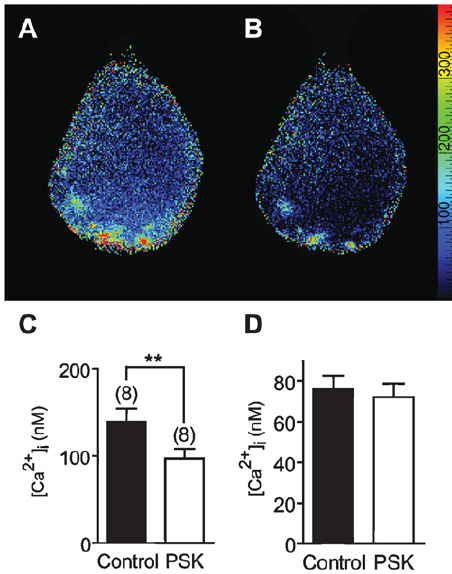
Figure 9. Calcium imaging of the effect of 10nM PSK on [Ca 2 þ ] i in an isolated DUM neuron . ( A ) Distribution of [Ca 2 þ ] i under control conditions. The primary neurite of the cell is directed upward, the apical pole is downward. ( B ) Distribution of [Ca 2 þ ] i 8minutes after application of PSK. Scale bar, 20 m m. The color scale gives [Ca 2 þ ] in nM. ( C , D ) Mean [Ca 2 þ ] i in the absence (Control) and in the presence of 10nM PSK. PSK causes a significant overall reduction of [Ca 2 þ ] i (paired t-test; p < 0.01; C), yet in the basal part [Ca 2 þ ] i was not significantly changed (D)